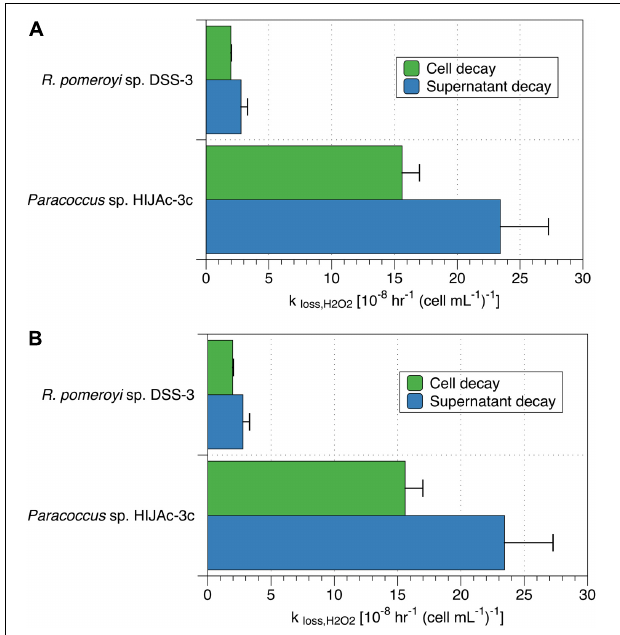
FIGURE 2 | Comparison of (A) decay rate coefficients and (B) production rates for cells and supernatant in cultures of R. pomeroyi sp. DSS-3 and Paracoccus sp. HIJAc-3c. Production and decay data in the supernatant are normalized to the number of cells originally grown in that medium for comparison